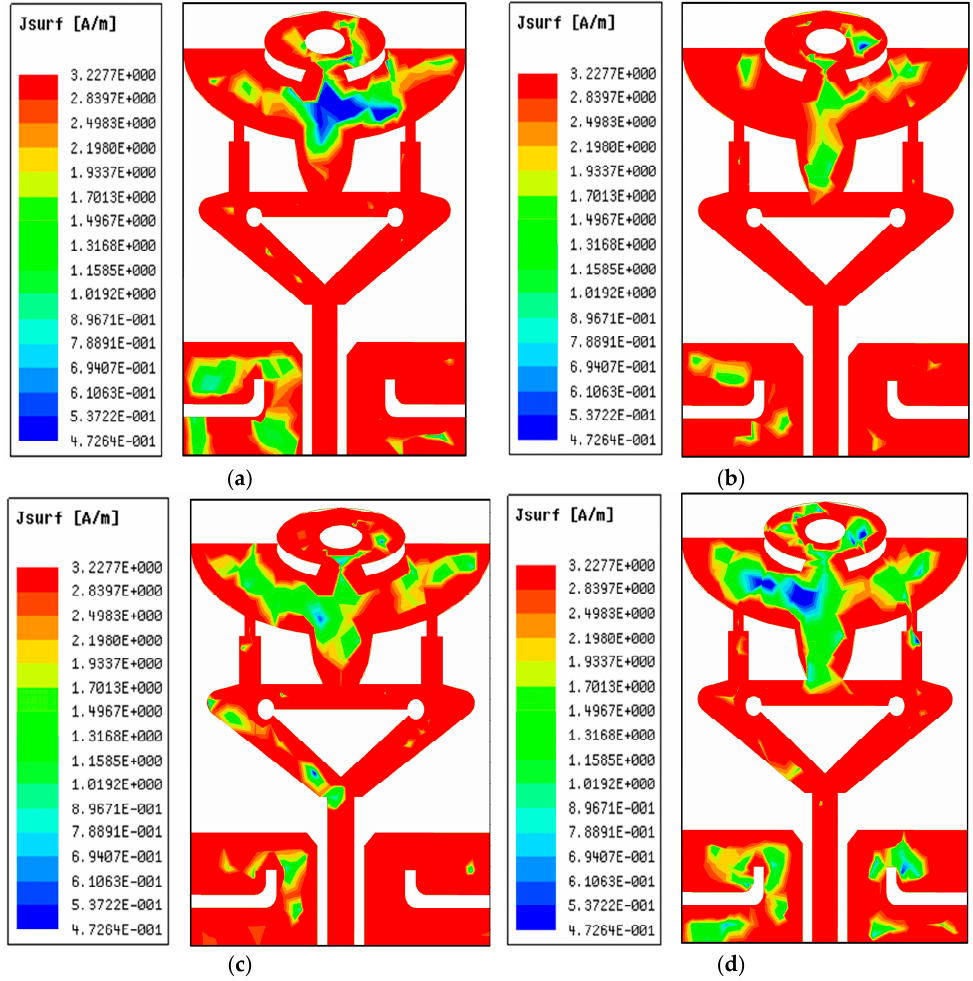
Figure 7. Surface current distribution (J SURF ) at multiple frequencies: ( a ) 26.25 GHz, ( b ) 29.75 GHz, ( c ) 35.65 GHz, and ( d ) 38 GHz of the proposed antenna structure.